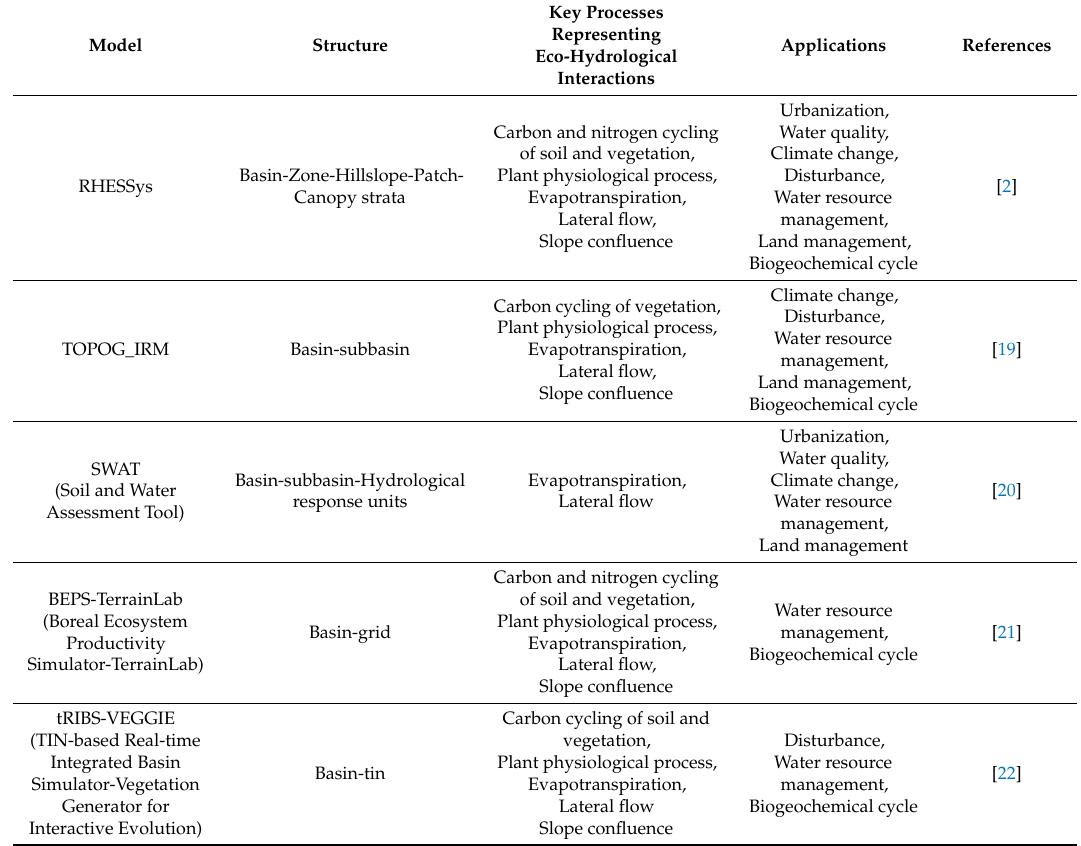
Table 1. Characteristics of RHESSys and ecohydrological models used in